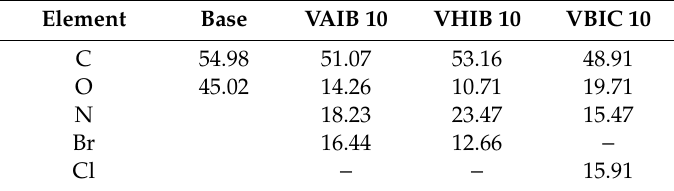
Table 2. The EDX analysis for the % compositions of hetero atoms in responsive membranes.